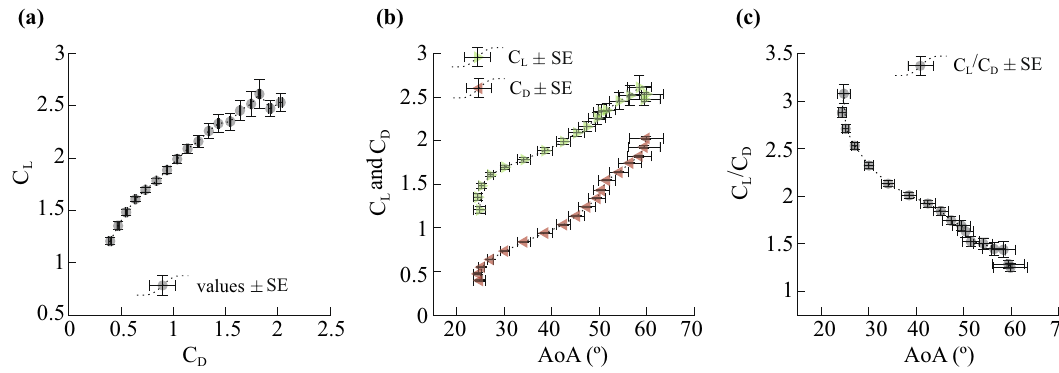
Figure 4. Aerodynamic performance of Draco gliding lizards recorded in the field motion capture arena. ( a ) A drag polar plot of the aerodynamic force coefficients; ( b ) their variation with the angle of attack (AoA). Note the expected gradual increase in each of the force coefficients with the increase in AoA up to a value of ~ 55°. ( c ) The lift-to-drag ratio shows a non-linear negative trend with respect to AoA. Because the underlying data are binned by C D , AoA ( b , c ) is not strictly increasing with respect to C D or C L /C D due to camber and inter-individual